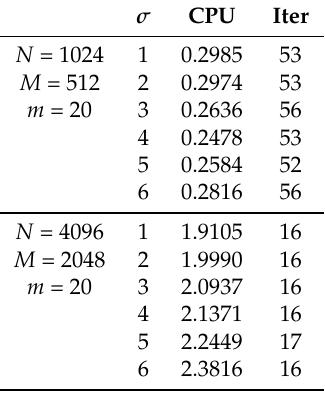
Table 5. The convergence behavior Algorithm 4 with different cases of σ . σ